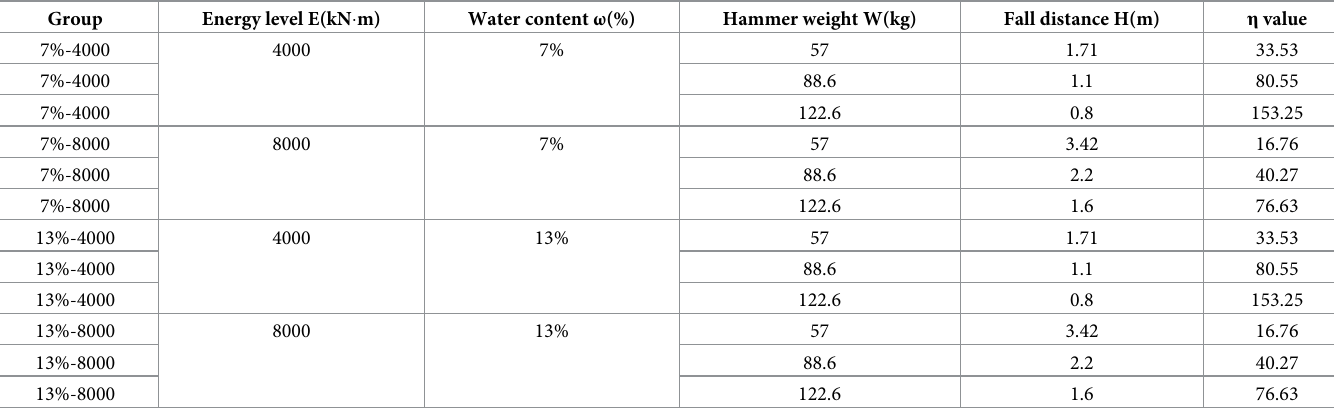
Table 4. Experimental scheme with different η values.